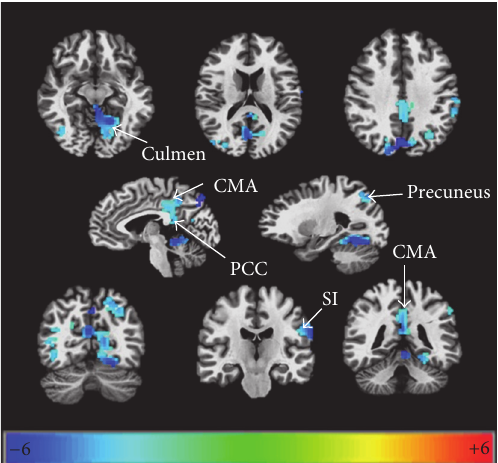
Figure 3: Cortical reorganization in the areas of palsy recovered group compared to healthy control group when conducting lip pursing movements. 𝑃 = 0.05 , 𝛼 < 0.05 , corrected with Monte-Carlo method. PCC: posterior cingulate cortex; SI: primary somatosensory